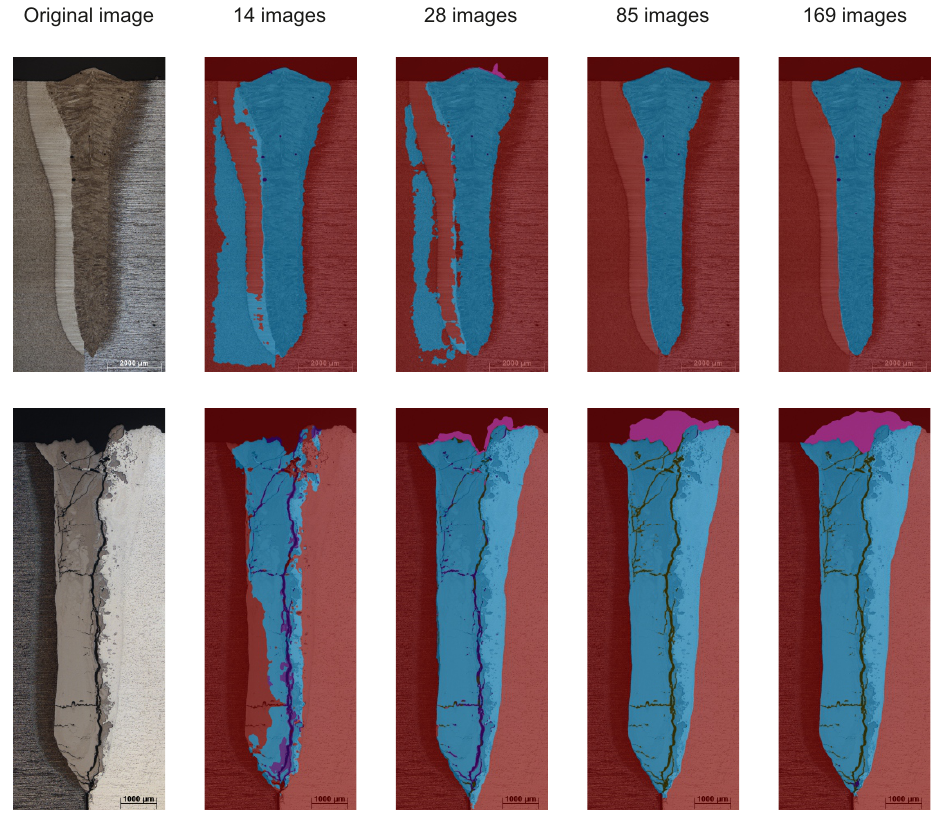
Figure 5. Prediction results depending on the amount of training data of 14 to 169